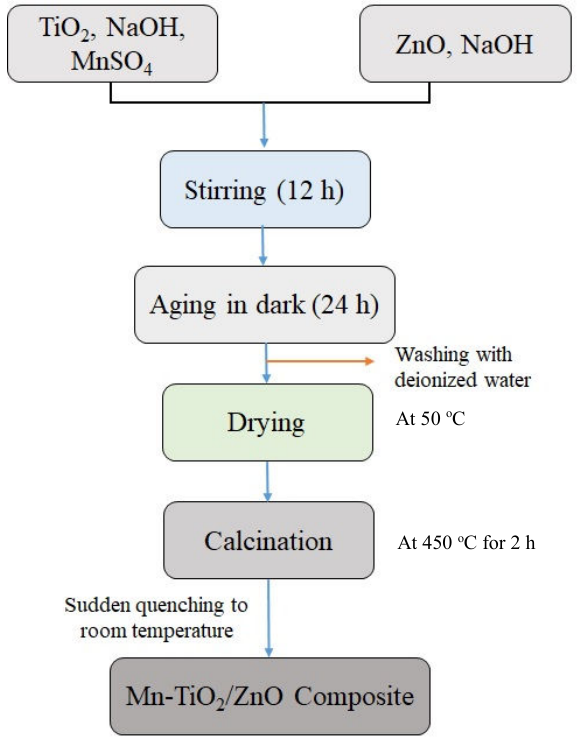
Fig. 1. Schematic of Mn-TiO 2 /ZnO composite preparation through sol-gel process